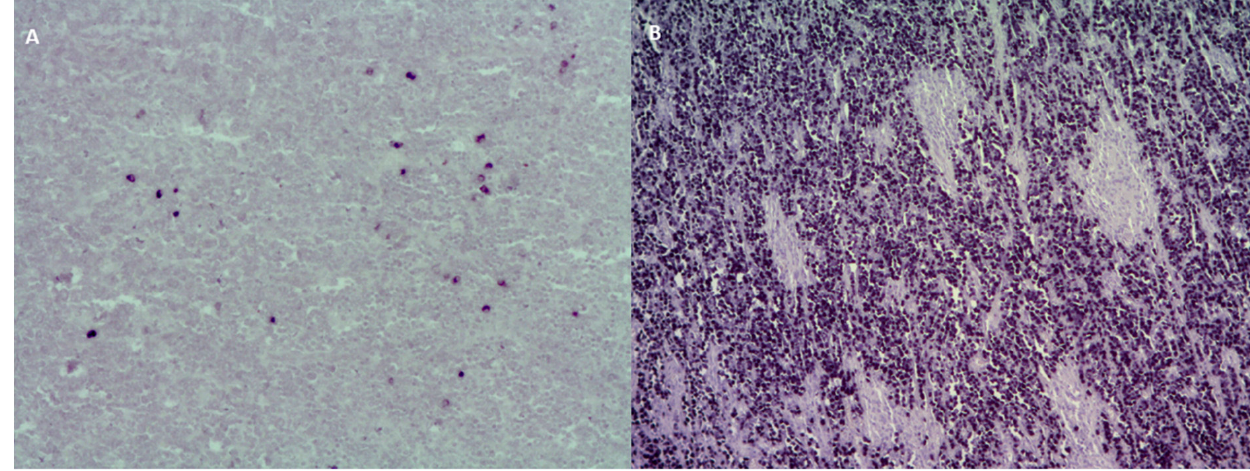
Figure 1. EBERs positive staining at the nucleus of ( A ) < 10% of tumor cells and ( B ) 90% of tumor cells. Magnification 100×.